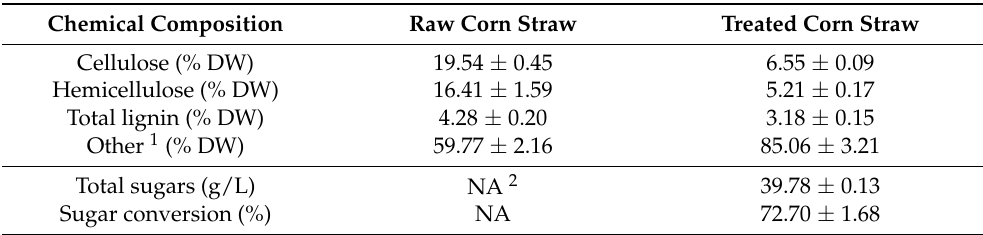
Table 1. Chemical composition of corn straw before and after thermochemical pretreatment and enzymatic hydrolysis. Chemical